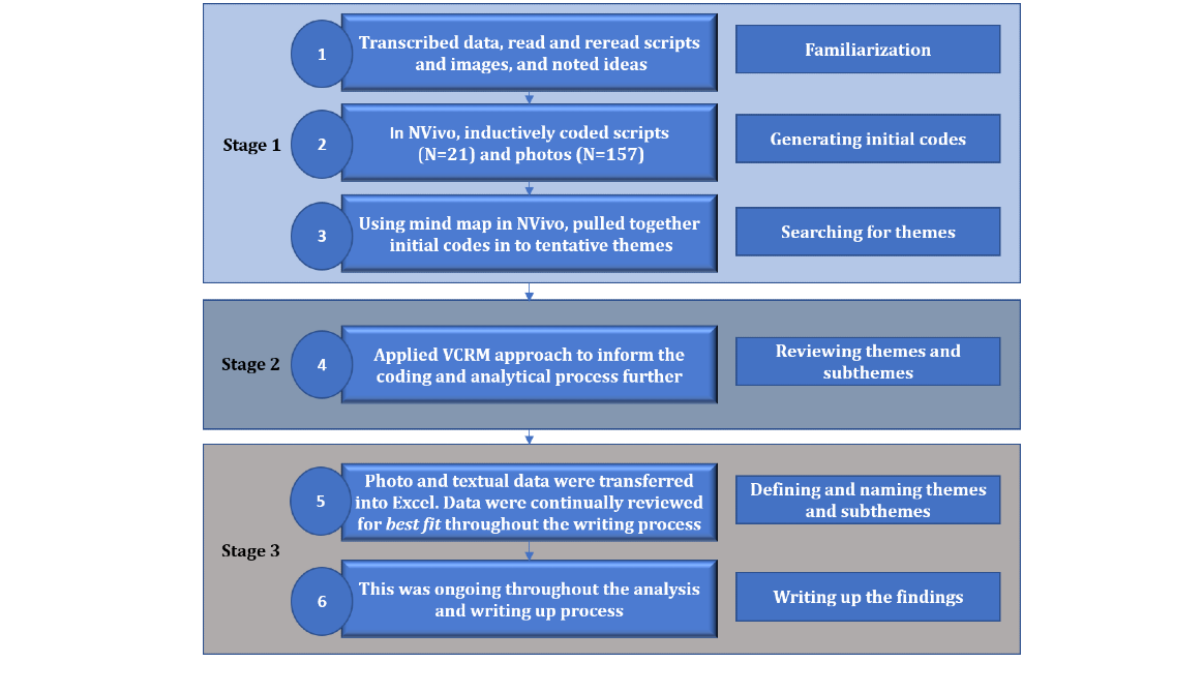
Figure 1. Data analysis process flowchart. (VCRM: voice-centered relational